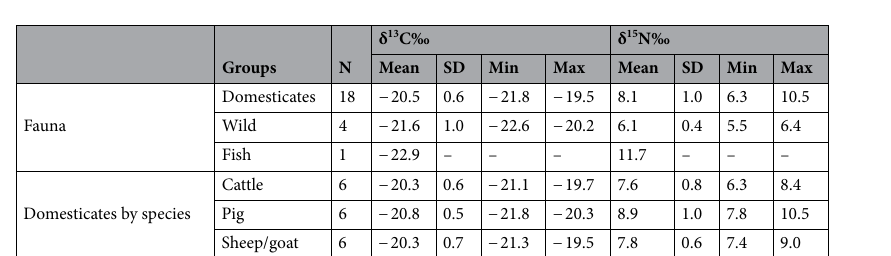
Figure 3. Boxplot representing ( A ) the total number and ( B ) length of striations, ( C ) the vertical and ( D ) horizontal indexes for buccal microwear of Middle Neolithic sites. Samples only include individuals > 8 years old (N = 14; see text for explanation). Red triangles show the means, the horizontal lines represent the medians. Sites: Bükkábrány-Bánya VII (BB-VII, n = 4); Bükkábrány-Bánya XI/A (BB-XI/A, n = 7); Bükkábrány-Bánya XII/B (BB-XII/B, n = 3).